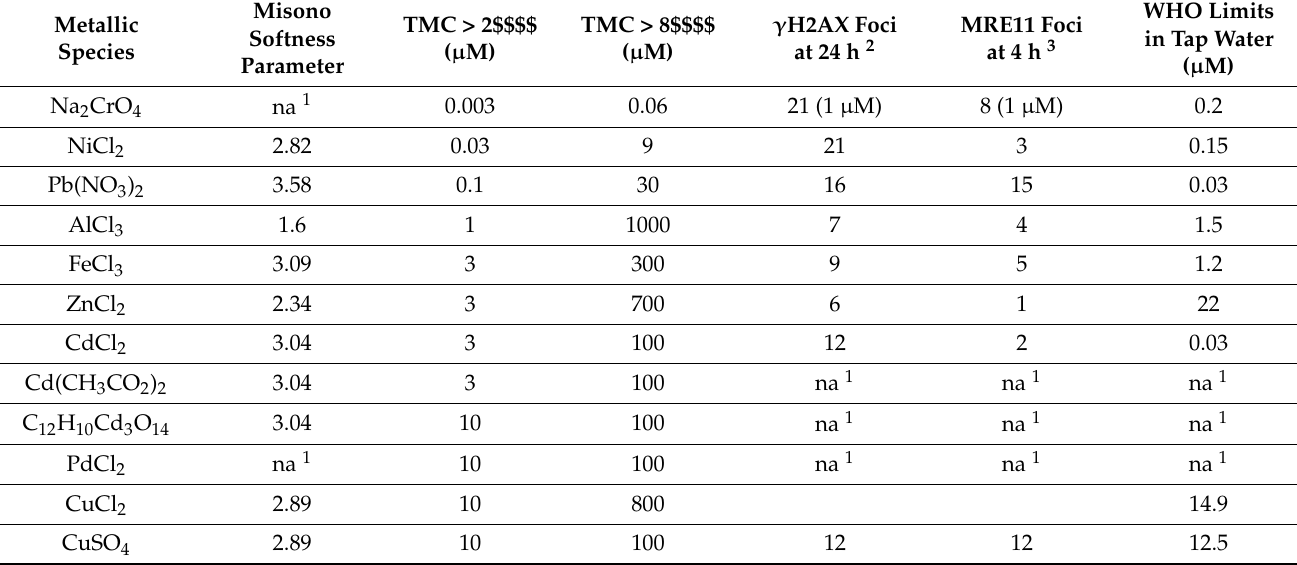
Table 2. Major biochemical and radiobiological values for the metallic species tested.